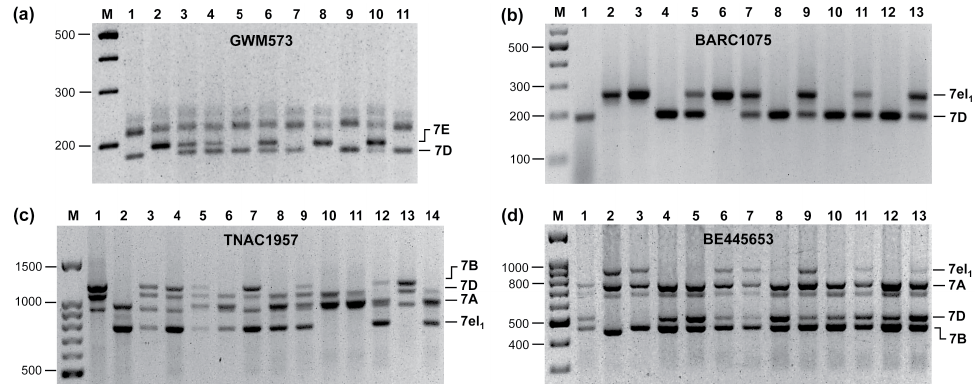
Figure 4. Profiles of some PCR-based markers used to select recombinant chromosomes with gene combinations from Th. ponticum 7el 1 L and Th. elongatum 7EL arms in cross progenies of (CS7E(7D) × T4) F 1 s with normal bread wheat cultivars (CS and Blasco). Group-7 wheat and Thinopyrum spp. alleles are indicated. ( a ) GWM573, a short arm-linked marker (7DS and 7ES alleles), allows discrimination between T4 and 7E chromosome types (both parental and recombinant):